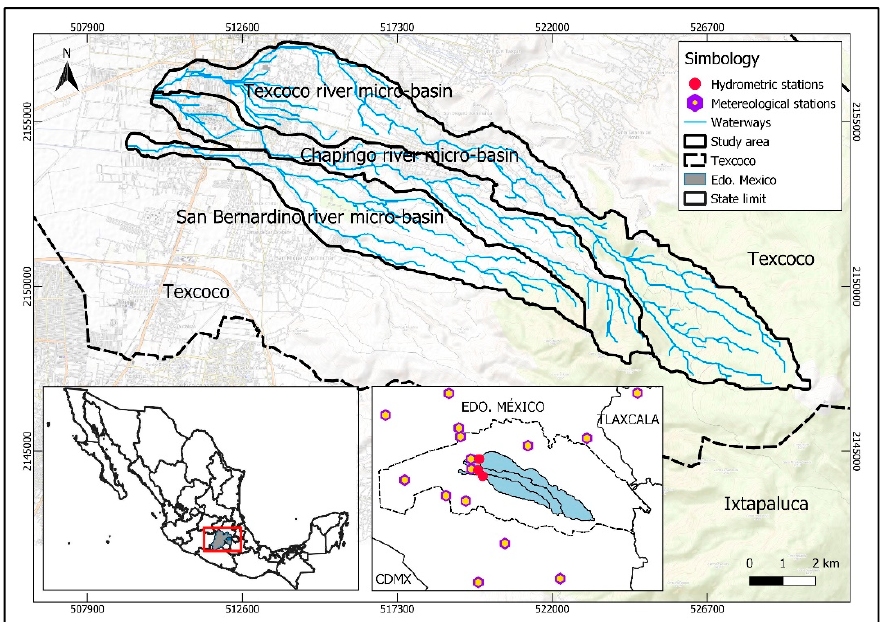
Figure 1. Geographic location of the study area.